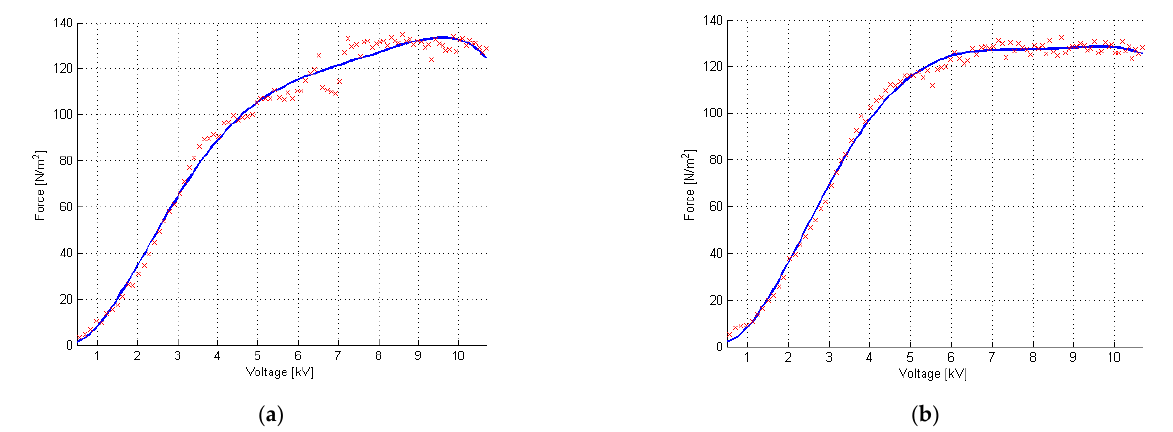
Figure 8. Dependence of the force on the voltage increase. Measurements were performed for ( a )positive polarization, ( b ) negative polarization.